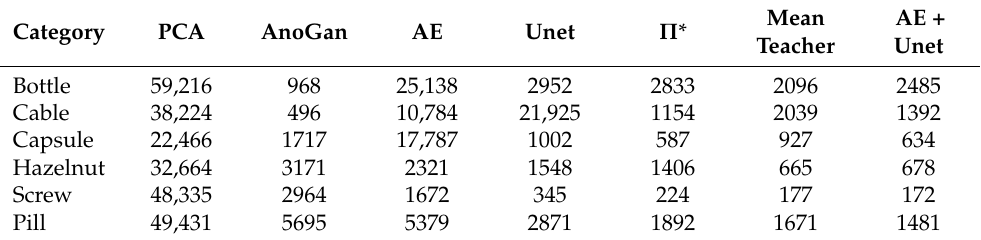
Table A2. Semantic segmentation performance of several evaluated methods. We report the mean ab- solute error (MAE) of the unsupervised PCA, unsupervised AnoGan, unsupervised autoencoder(AE), Unet, pi models ( Π * ), mean teacher, and our method (AE +